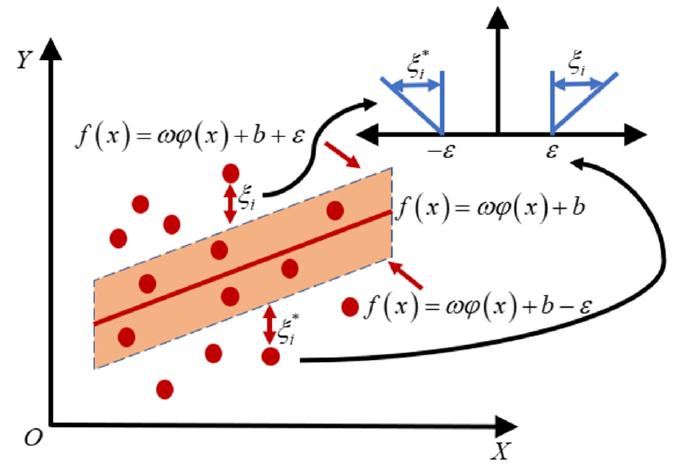
Figure 3. Support vector regression diagram.